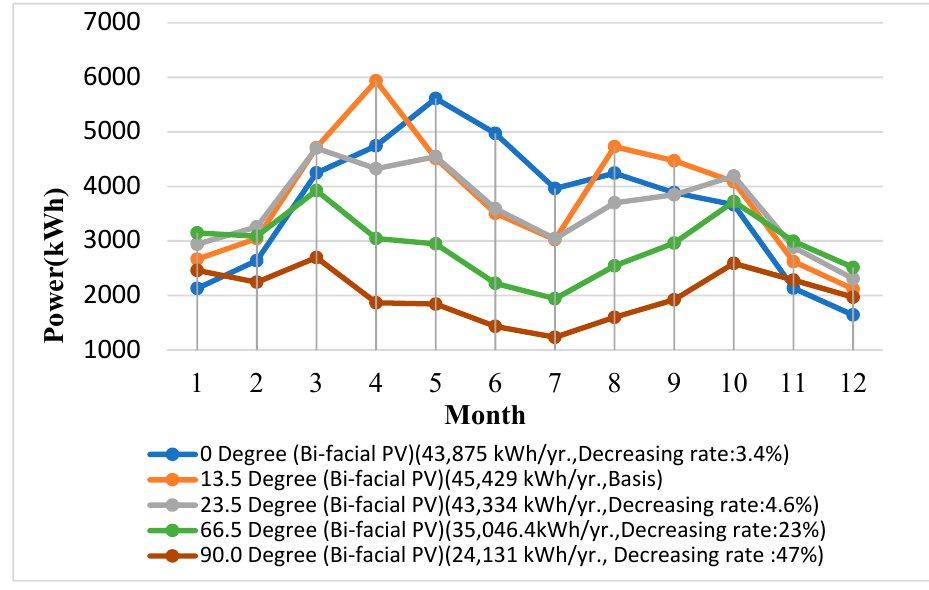
Figure 8. The simulation results for a power generation depending on the angle of the PV module.